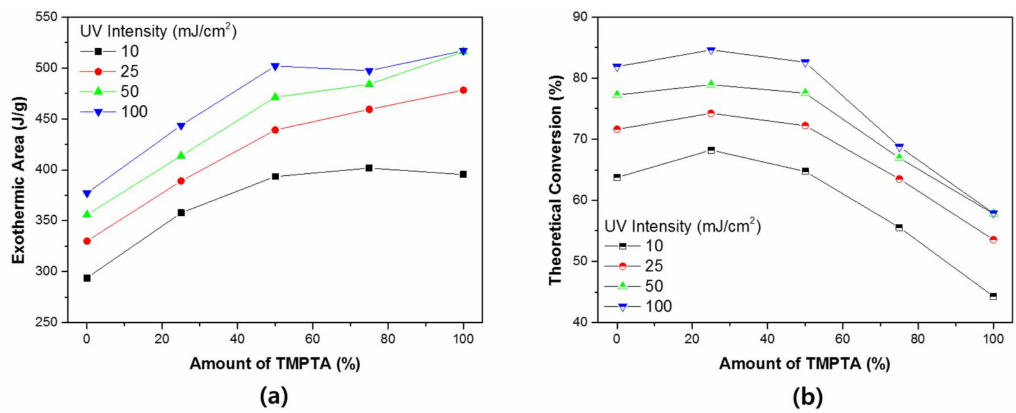
Figure 10. The theoretical double bond conversion ratio of the binary monomer system in accordance with the UV intensity: ( a ) experimental results; and ( b ) theoretical